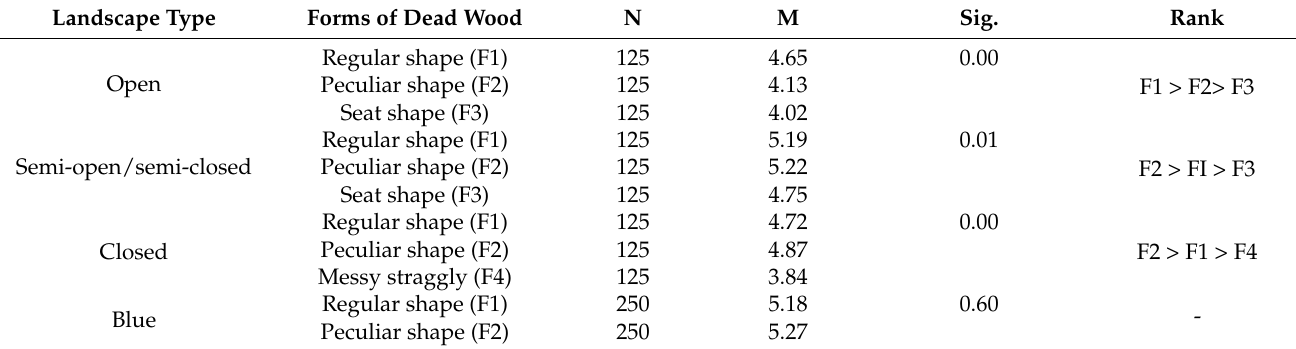
Table 5. The results of Tukey’s HSD Test between dead wood forms in each landscape